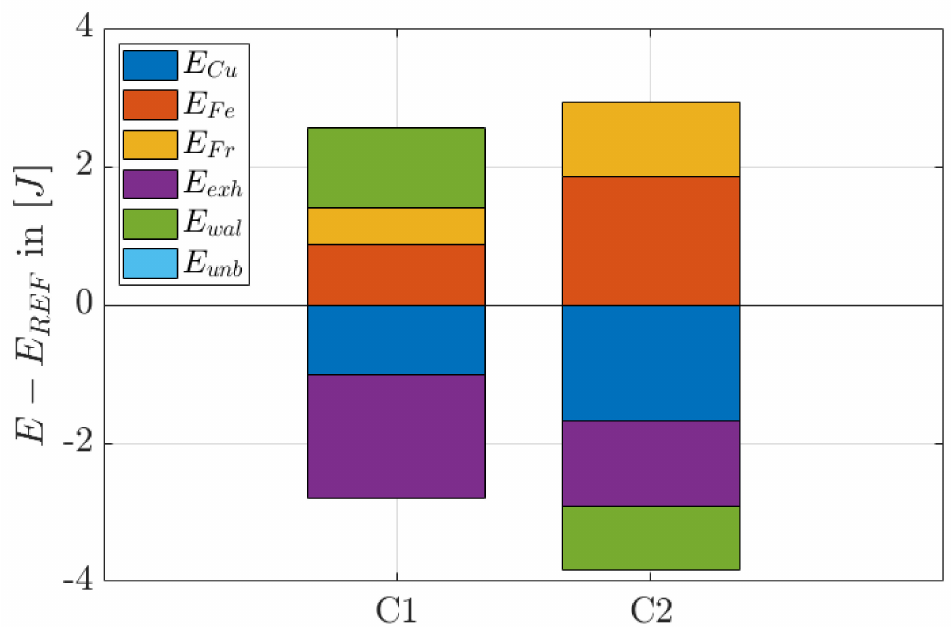
Figure 29. Energy losses for trajectory C1 and C2 with respect to REF.